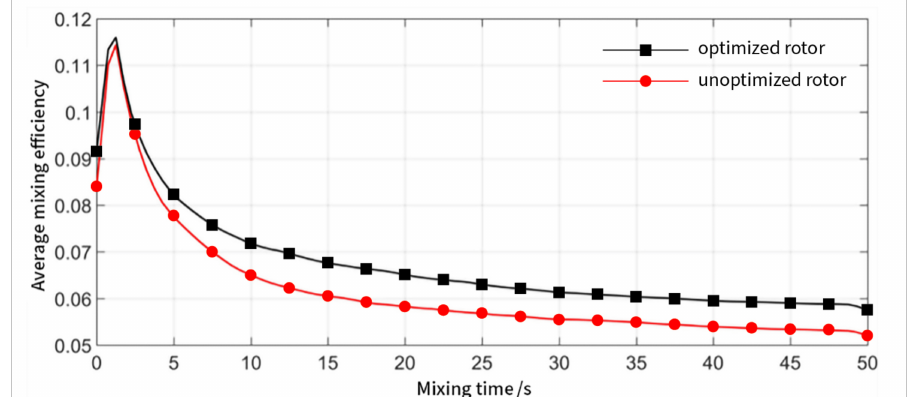
Figure 12. Average mixing e ffi ciency of the optimized rotor (black) and rotor before optimization (red) as a function of